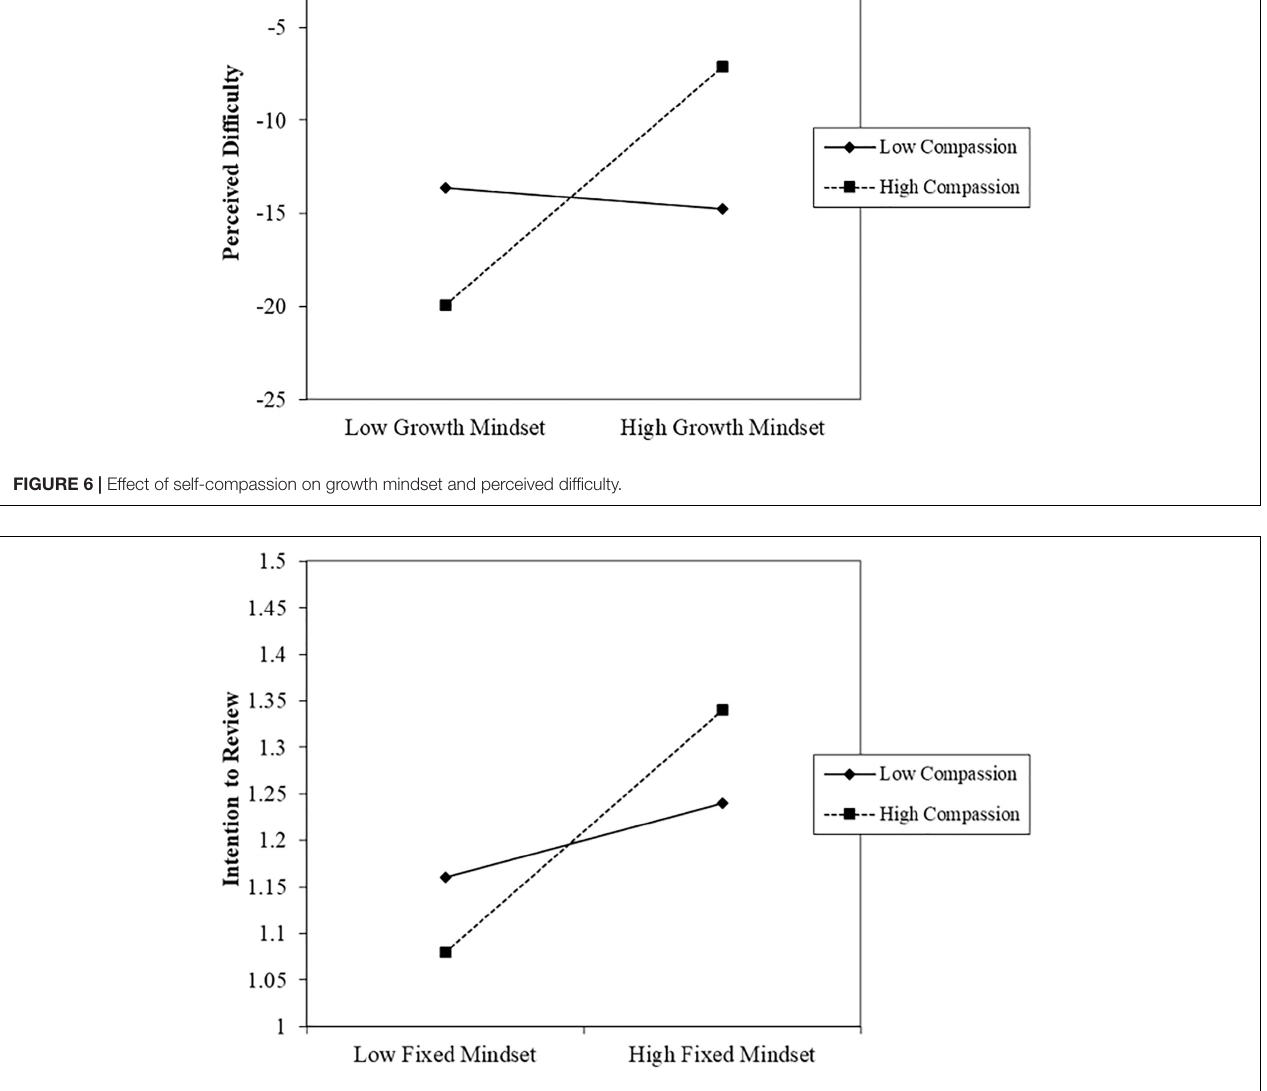
FIGURE 7 | Effect of self-compassion on fixed mindset and intention to